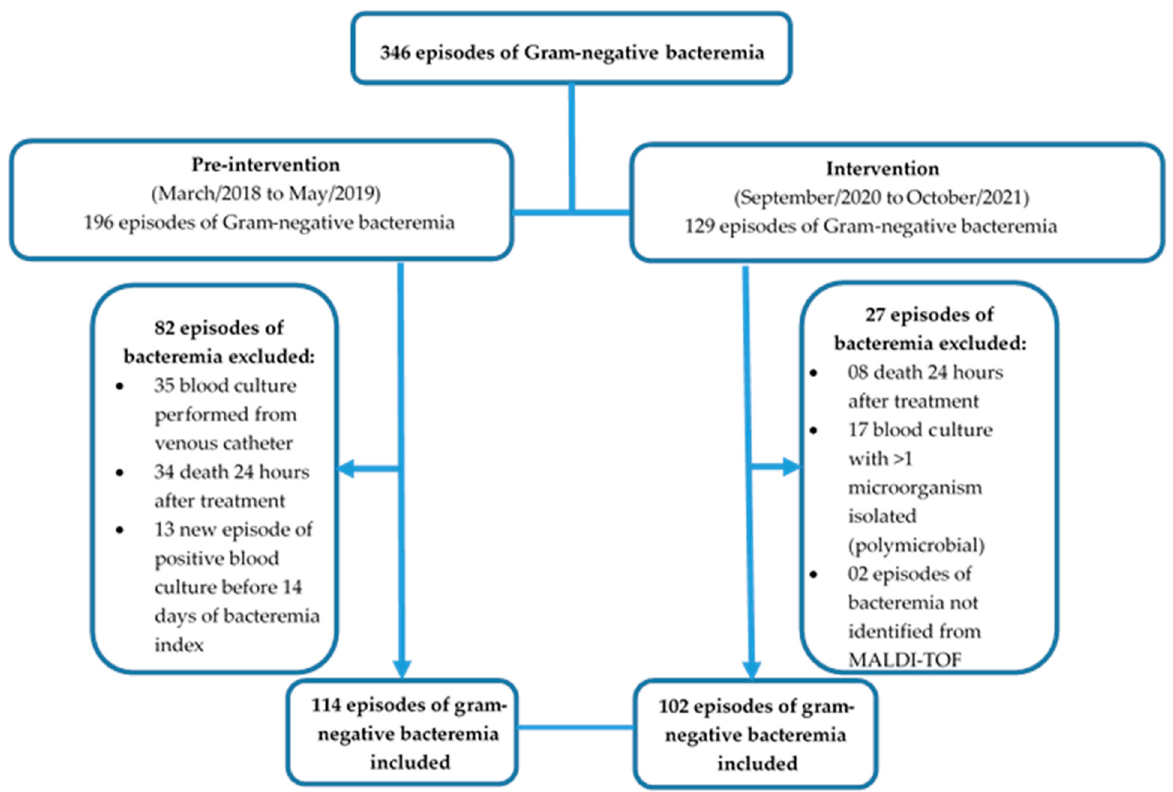
Figure 1. Patient selection flowchart.